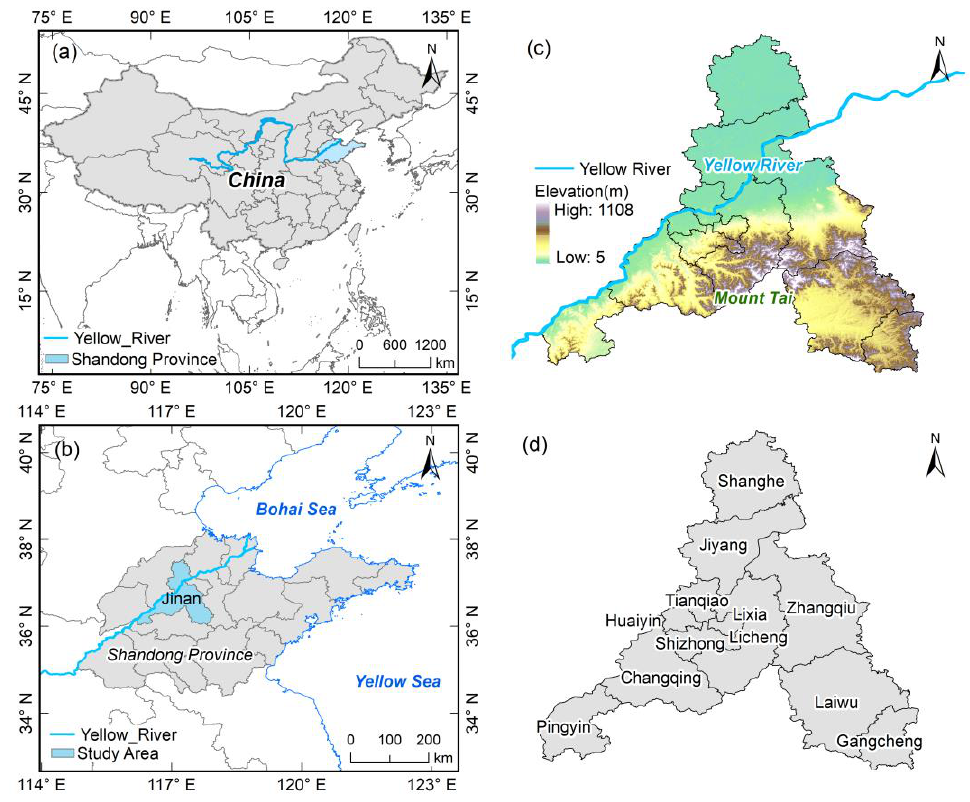
Figure 1. Overview of the study area: ( a ) location of the Shandong Province in China; ( b ) location of the study area in Shandong Province; ( c ) topography of the study area; ( d ) administrative division of the study area.